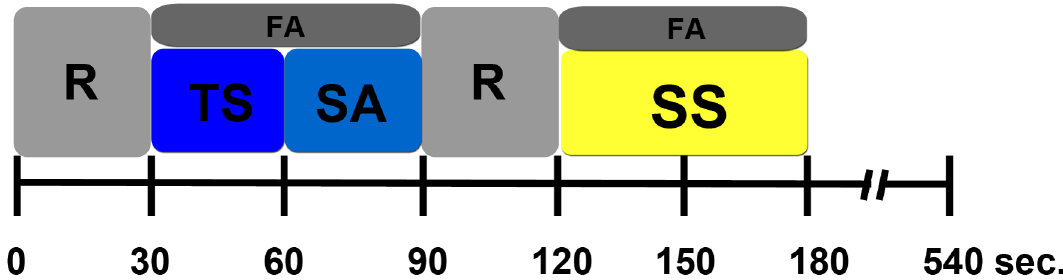
Figure 1. Single run experimental paradigm for either thumb. Touch-Stimulus (TS, in dark-blue), Stimulation-Aftereffect (SA, in light-blue) and Spontaneous-Sensation (SS, in yellow). Focusing attention (FA, in grey) was required during every condition. No attention task was required during resting periods between conditions (gaps).